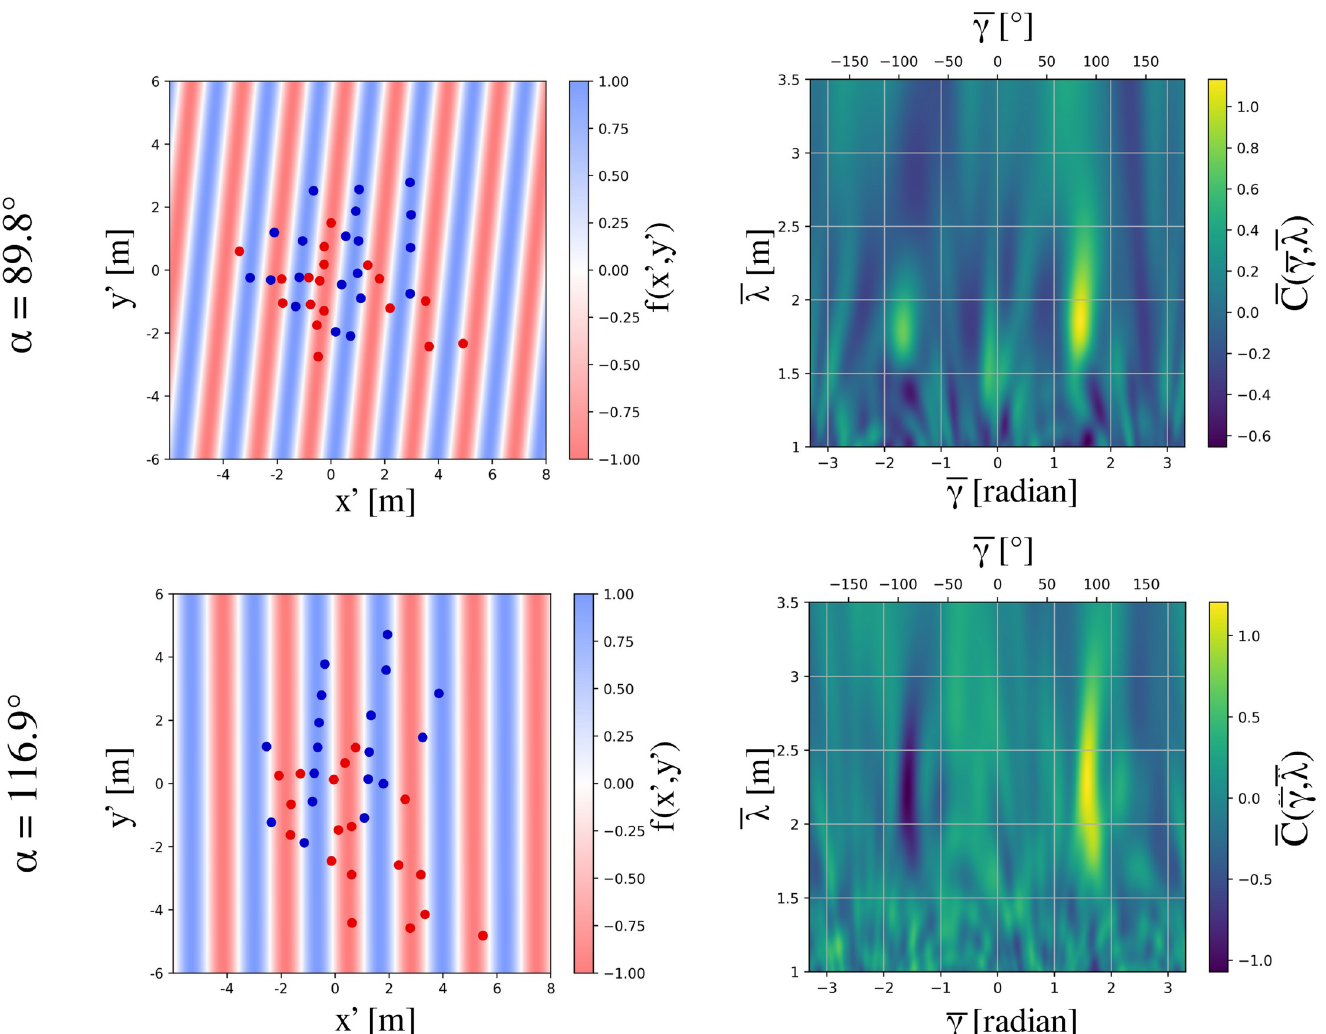
Fig 5. Output of the pattern matching technique. The panels on the left show fitting of pedestrian positions for the same trials shown in Fig 4. Fitting was done using the parametric sine curve f and the transformed coordinates ( x 0 , y 0 ). The blue and red parts of the plot represent the crests and troughs of the sine function respectively. The outputs of the fitting are � g ¼ 83 : 34 � , � l ¼ 1 : 865 m and � c ¼ (cid:0) 116 : 37 � for the typical trial with α = 89.8˚ and � g ¼ 89 : 99 � , � l ¼ 2 : 286 m and � c ¼ (cid:0) 0 : 92 � for the typical trial with α = 116.9˚. (see Materials and methods) The panels on the right show variation of � C as a function of � g and � l keeping ψ fixed to the value obtained from the fitting shown in the left panel. The region of occurrence of high values of � C is shown in yellow. The function � C was maximised to fit the sine function f . The maximum value of � C for the trial with α = 89.8, as obtained by our optimisation procedure is 1.132, which occurred for � g ¼ 83 : 34 � and � l ¼ 1 : 865 m . Whereas, for the trial with α = 116.9˚ we obtained the maximum value of � C ¼ 1 : 205 , which occurred for � g ¼ 89 : 99 � and � l ¼ 2 : 286 m .